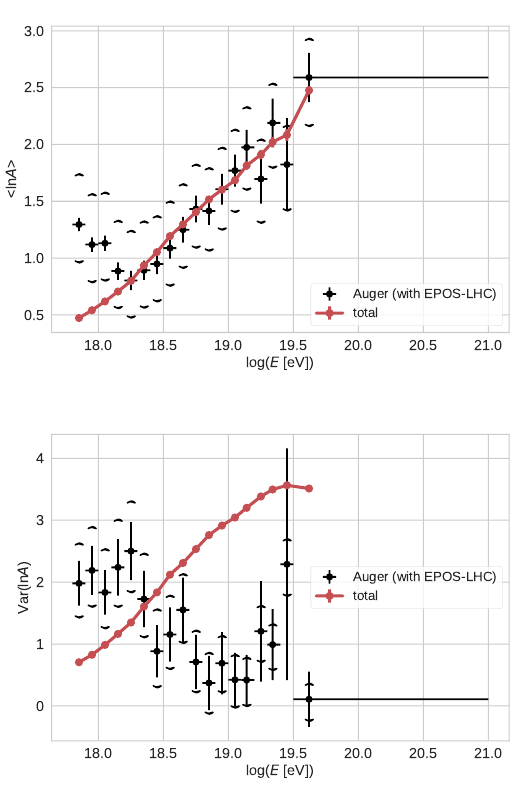
Figure 2. (cid:104) ln A (cid:105) (left figure) and Var(ln A ) (right figure) based on the fit parameters of table 1. The observational data is taken from Auger